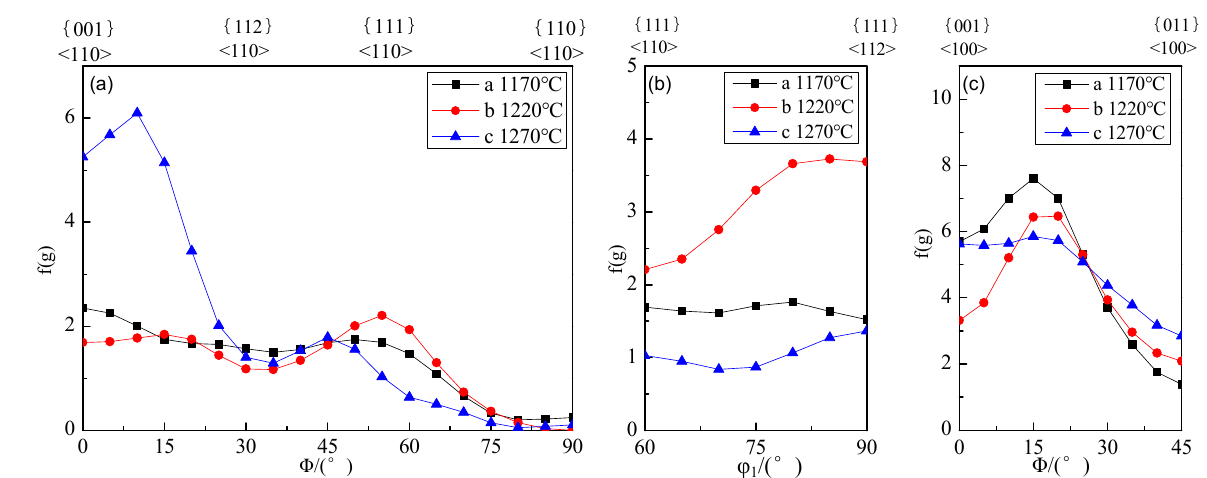
Figure 6. Orientation distribution intensities along ( a ) α‐ fiber, ( b ) γ‐ fiber, and ( c ) η‐ fiber after first cold rolling with different slab heating temperatures.